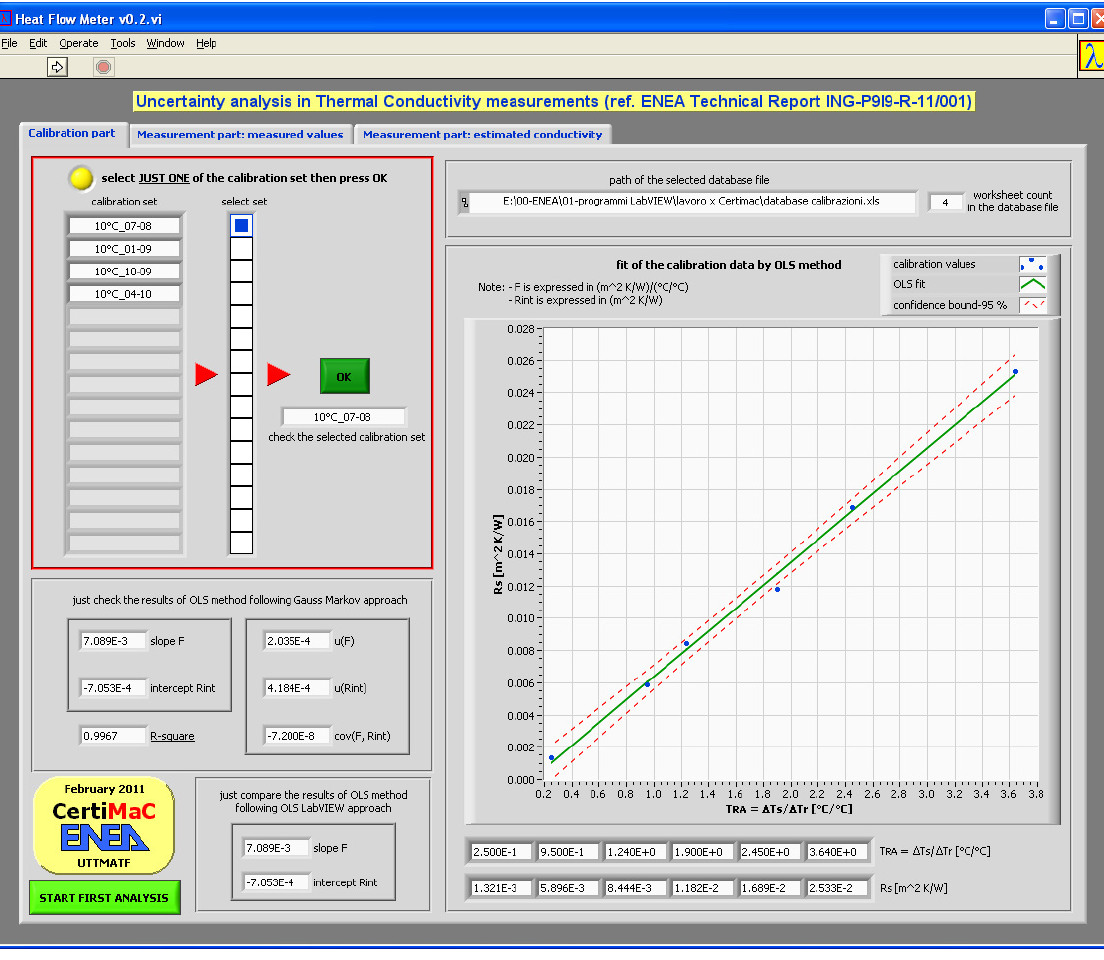
Fig. 7. (Color online) Software Snapshot – Sheet 1: calibration part.